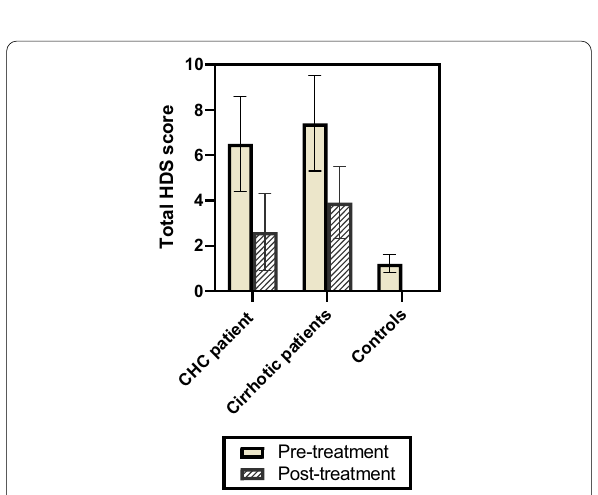
Fig. 3 Total HADI score among the studied